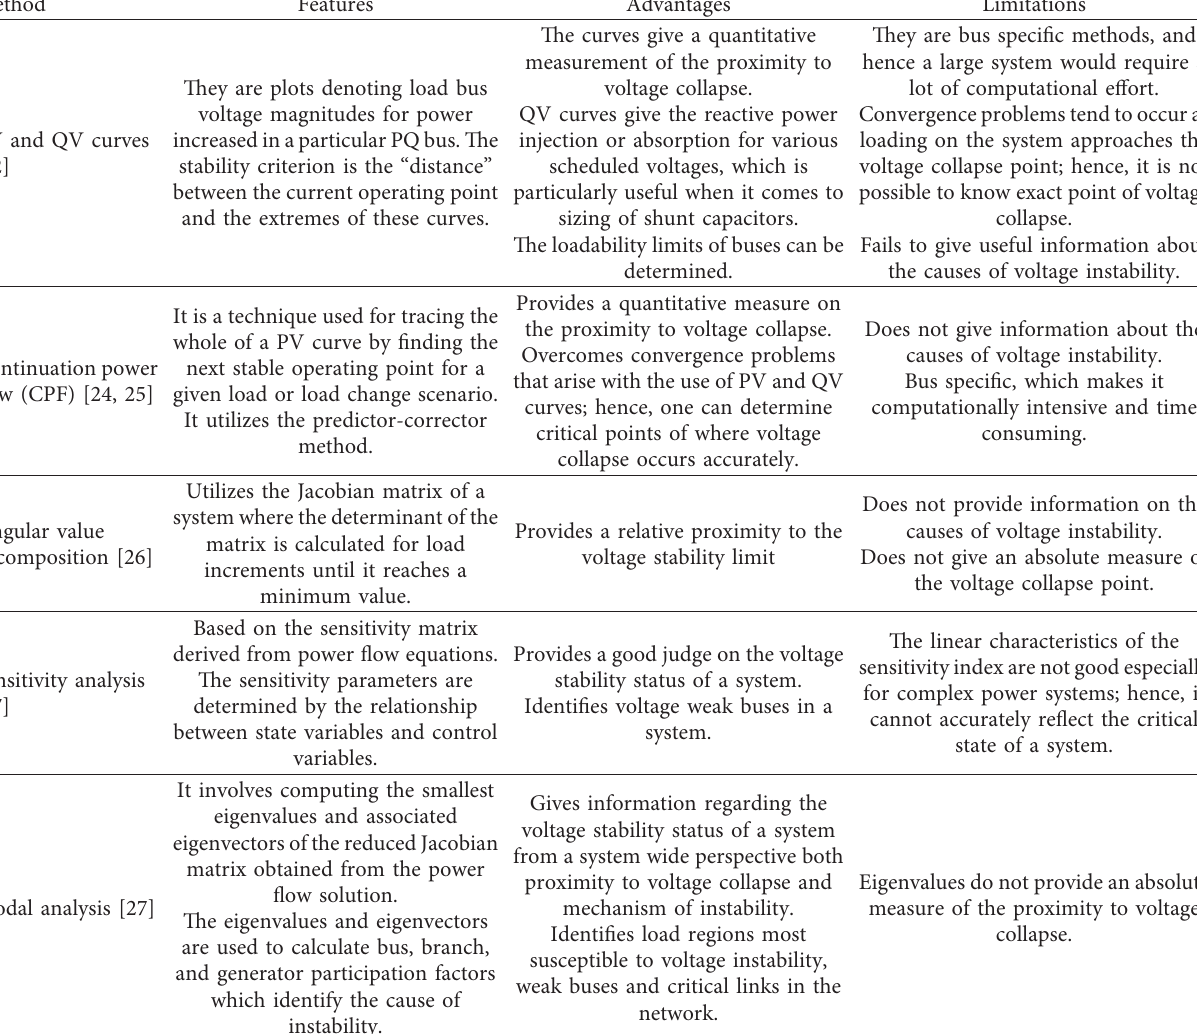
Table 3: Summary of popular static voltage stability analysis